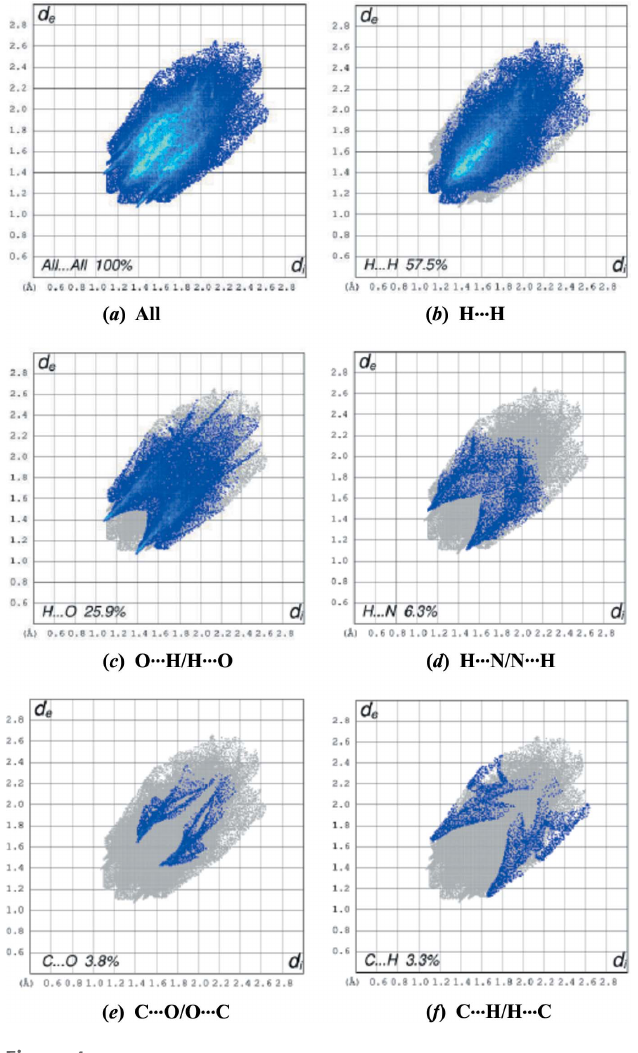
Figure 4 The two-dimensional fingerprint plots of the title compound, showing ( a ) all interactions, and delineated into ( b ) H (cid:3)(cid:3)(cid:3) H, ( c ) O (cid:3)(cid:3)(cid:3) H/ H (cid:3)(cid:3)(cid:3) O, ( d ) H (cid:3)(cid:3)(cid:3) N/N (cid:3)(cid:3)(cid:3) H, ( e ) C (cid:3)(cid:3)(cid:3) O/O (cid:3)(cid:3)(cid:3) C and ( f ) C (cid:3)(cid:3)(cid:3) H/H (cid:3)(cid:3)(cid:3) C interactions [ d e and d i represent the distances from a point on the Hirshfeld surface to the nearest atoms outside (external) and inside (internal) the surface, respectively].